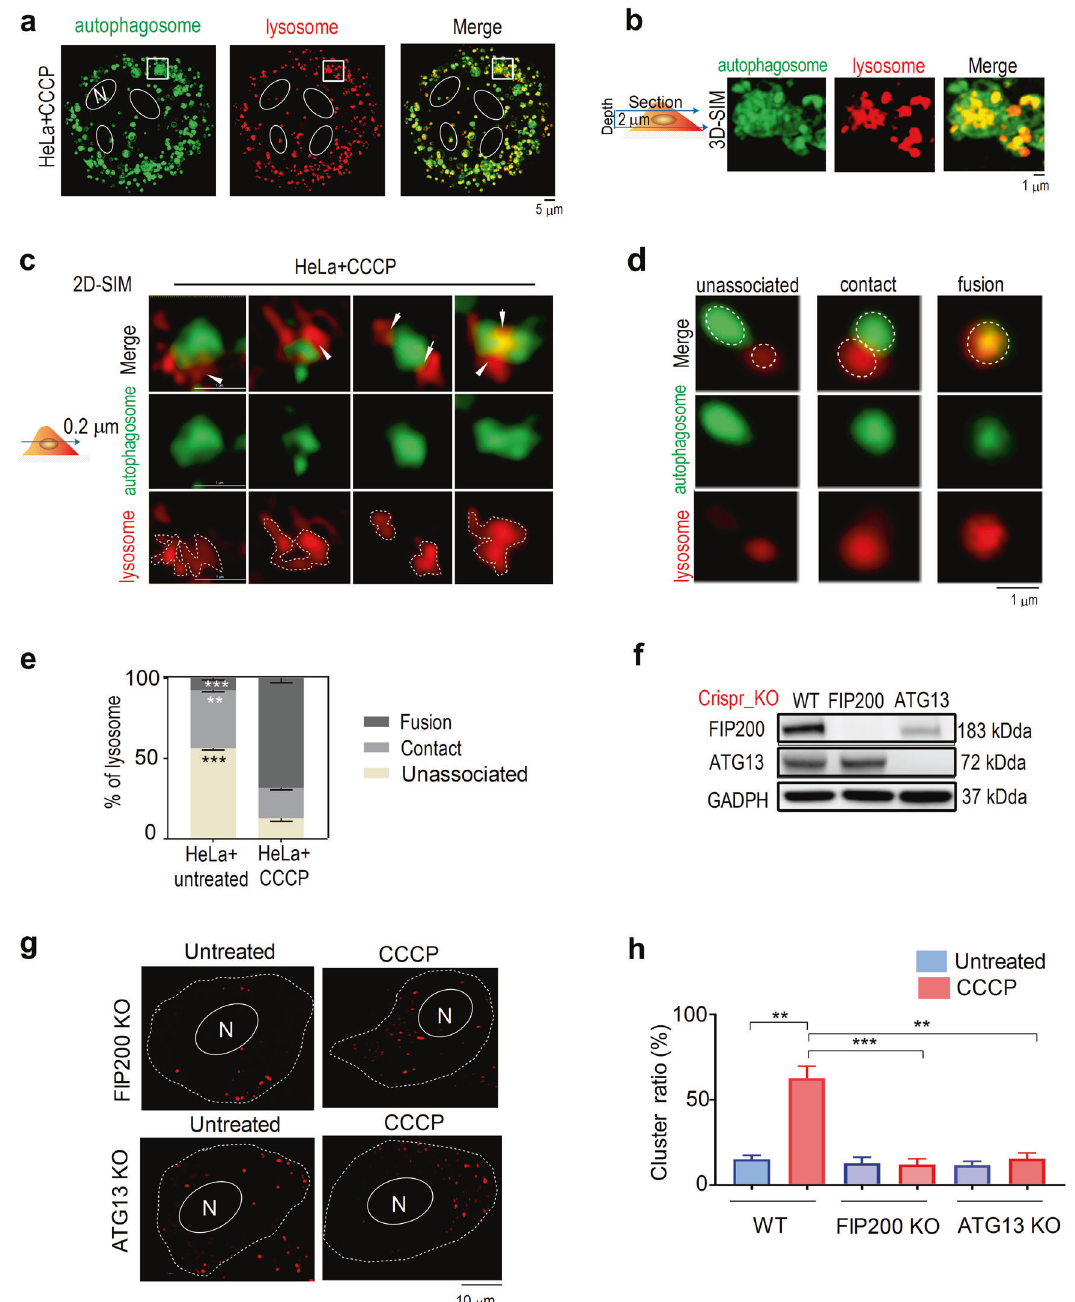
Fig. 2 Lysosome clusters associate with autophagosomes. a Co-localization of autophagosomes and lysosomes in CCCP-treated HeLa cells was observed by SIM. Autophagosomes and lysosomes were stained with 100 nM DAPGreen and 200 nM LTR, respectively, for 30 min to allow the investigation of lysosome – autophagosome association. b 3D SIM image of the enlarged region indicated by white rectangles in a . c Representative 2D SIM images of several lysosomes associated with one autophagosome in each CCCP-treated HeLa cell. d Representative events of lysosomes unassociated, in contact, and fused with the autophagosomes. e Percentage of lysosomes unassociated, in contact, and fused with autophagosomes using the de fi nition described in the text. f Western blot for detecting FIP200 and ATG13 protein expression in CRISPR-Cas9 gene-edited cells. g Lysosome puncta distribution in ATG13KO and FIP200KO HeLa cells with or without CCCP treatment. h The lysosome cluster ratio in WT, ATG13KO, and FIP200KO HeLa cells. Data in e and h are presented as mean ± SEM, * p < 0.05, ** p < 0.01, *** p <